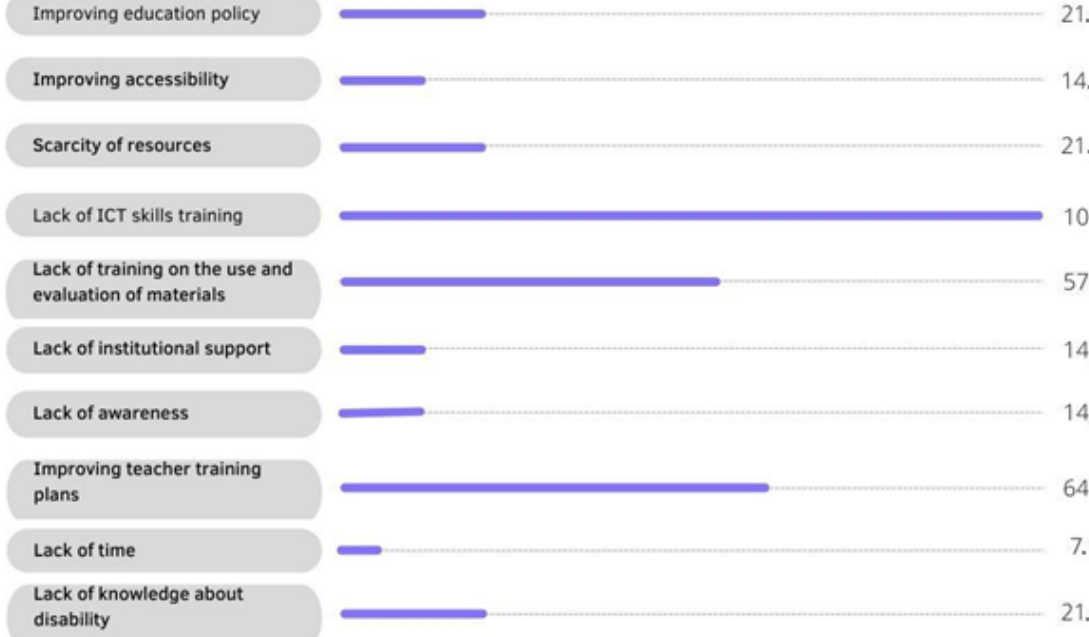
Figure 4. Quantitative analysis of obstacles.